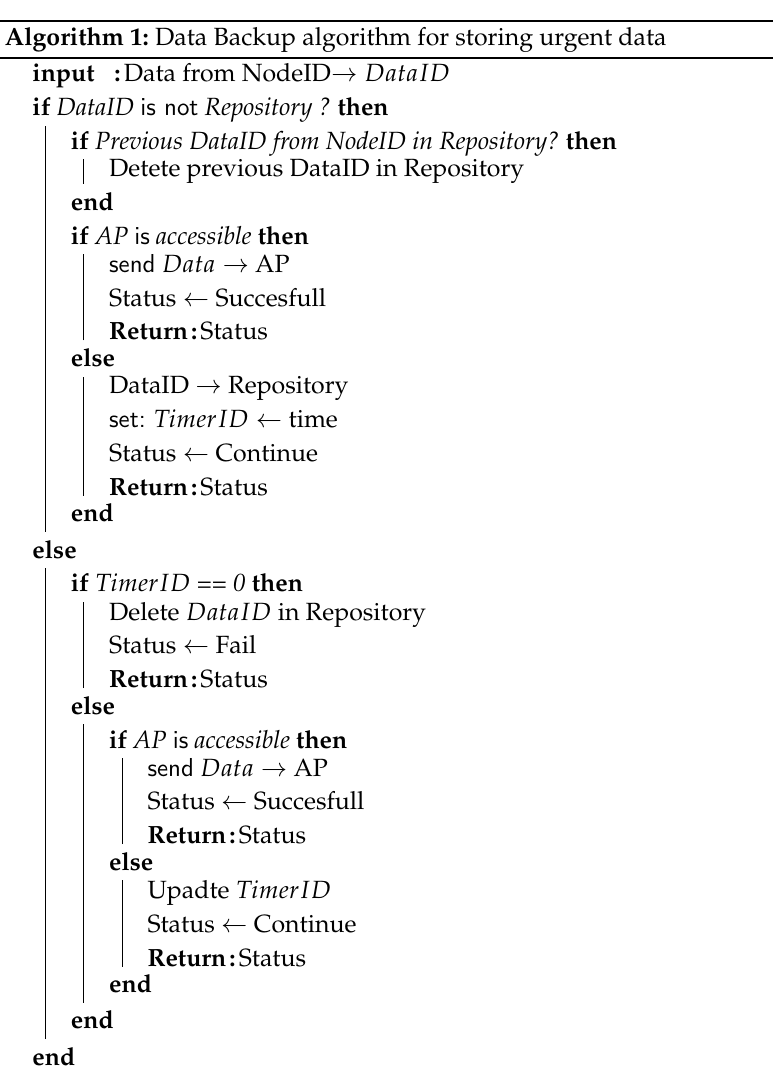
Algorithm 1: Data Backup algorithm for storing urgent